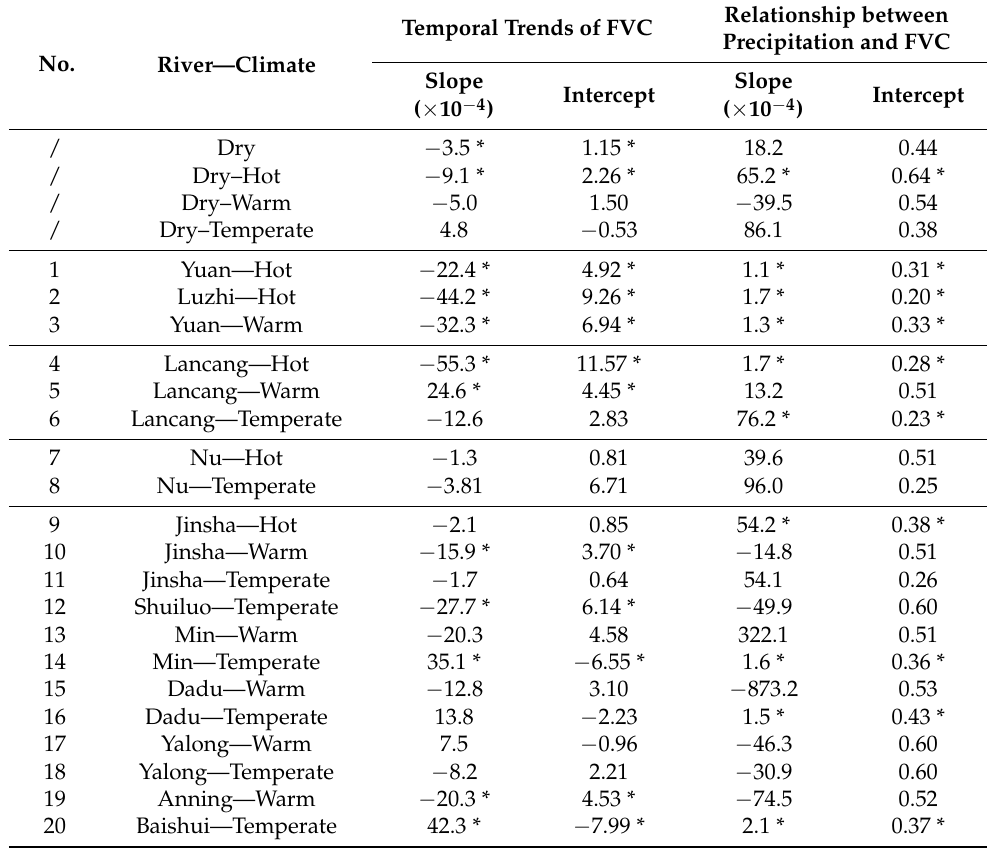
Relationship between Temporal Trends of FVC Precipitation and